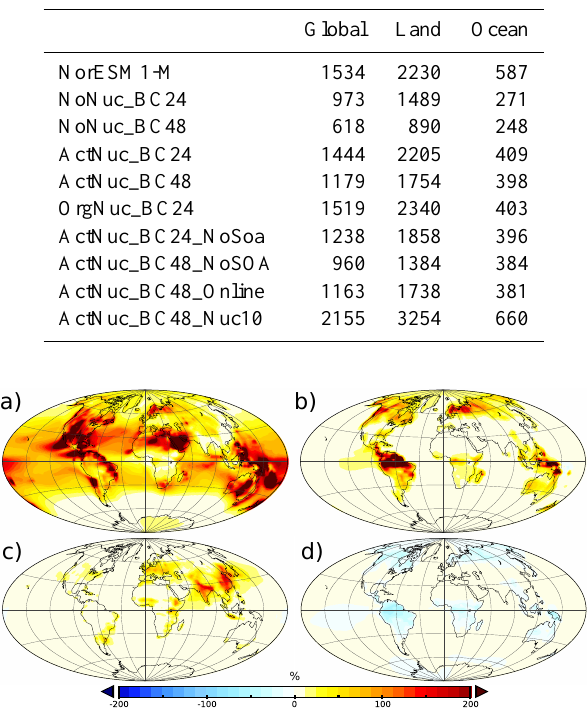
Table 2. Global average surface-level number concentrations (cm − 3 ) from model experiments.